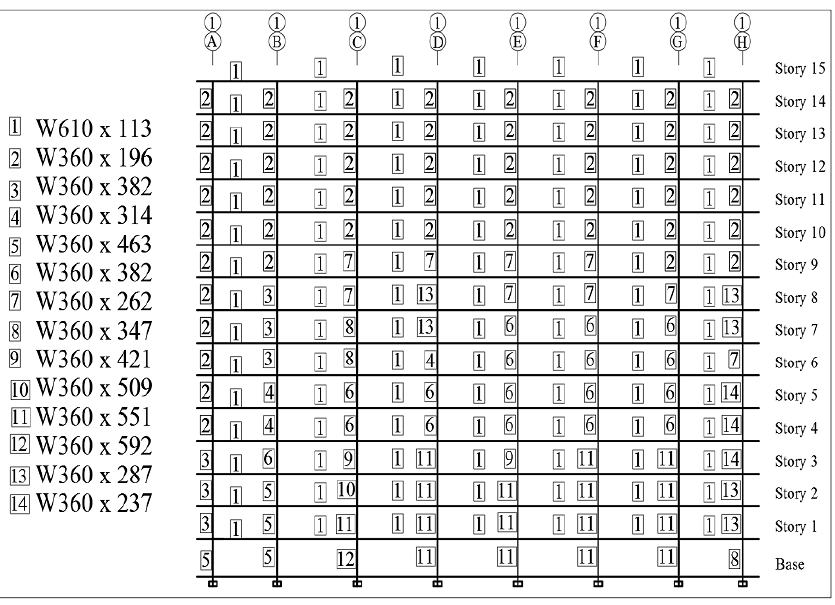
Figure 4. Designed sections for frames at elevations 1 and 6.